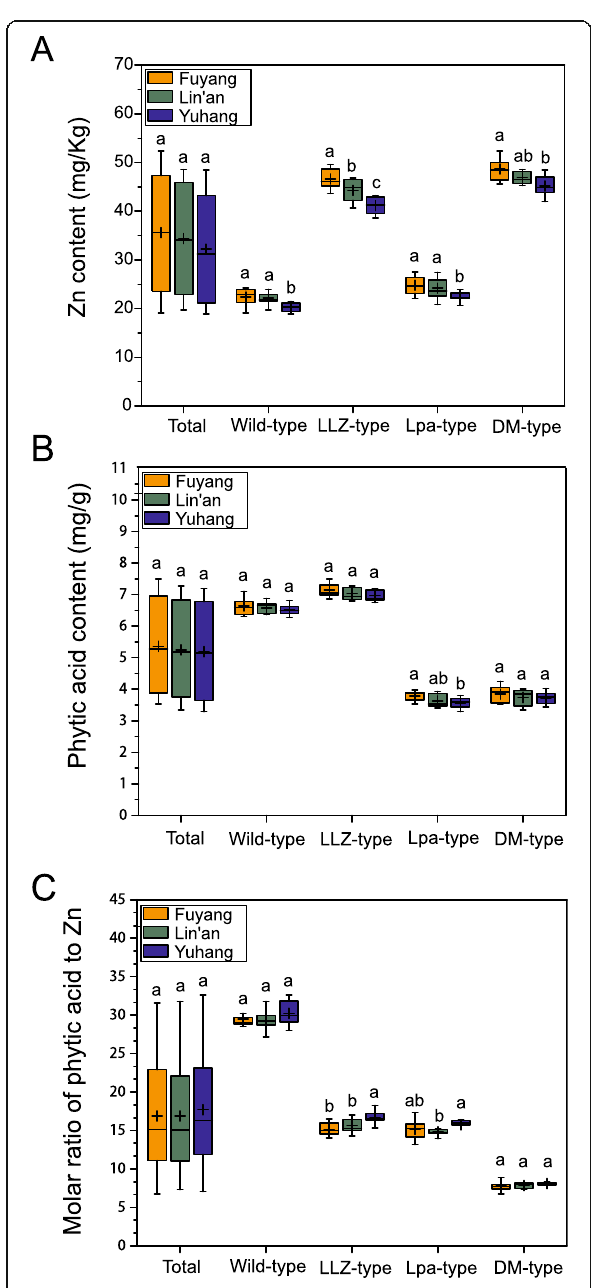
Fig. 3 Environmental impact on Zn and phytic acid contents in cross-bred progenies. Three rice lines for each type of progenies were planted at three sites (Yuhang, Fuyang and Lin ’ an). a Zn content in the brown rice. b Phytic acid content in the brown rice. c Molar ratio of phytic acid to Zn in the brown rice. The results are presented as box-and-whisker plots. Plus symbol: mean value; line in the box: median value; bottom and top of the box: first quartile (Q1) and third quartile (Q3); upper whisker: top of box + 1.5 × interquartile range (IQR = Q3 - Q1); lower whisker: bottom of box - 1.5 × IQR. Different letters indicate statistically significant differences by LSD ( P <